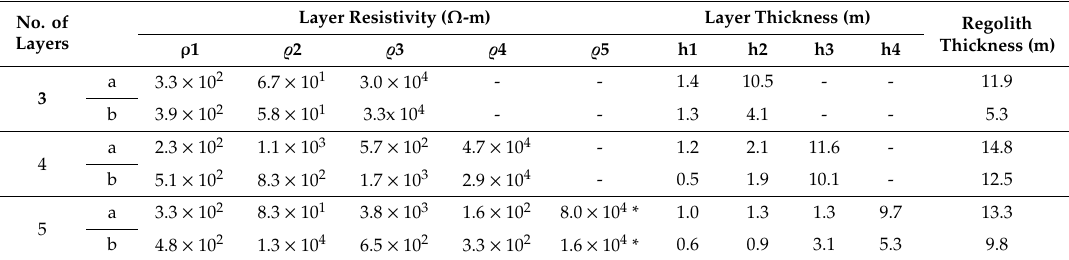
Table 4. Average resistivity and thicknesses of geo-electric layers beneath termite mounds and control areas.